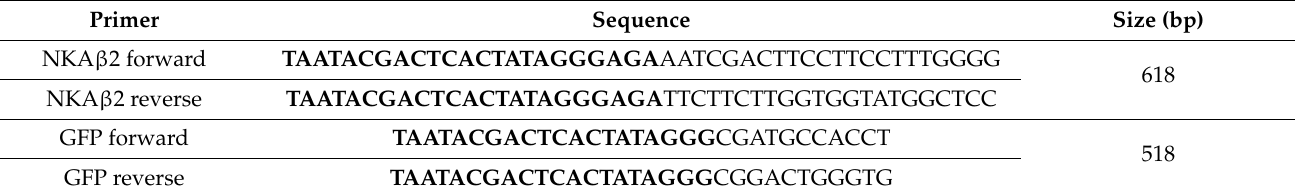
Table 2. dsRNA synthesis